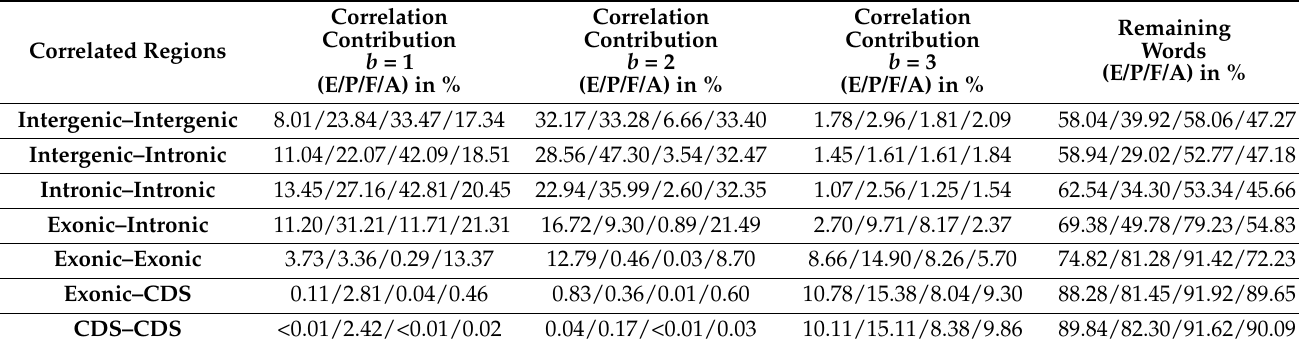
Table 3. Correlation contributions of tandem repeats words ( k = 11) for different chain seed lengths b (1 ≤ b ≤ 3). The correlation contributions for correlations between different genomic regions analogous to the data shown in Figure 4 are shown. (E/P/F/A) stands for ( Embryophyta / Protista / Fungi/Animalia